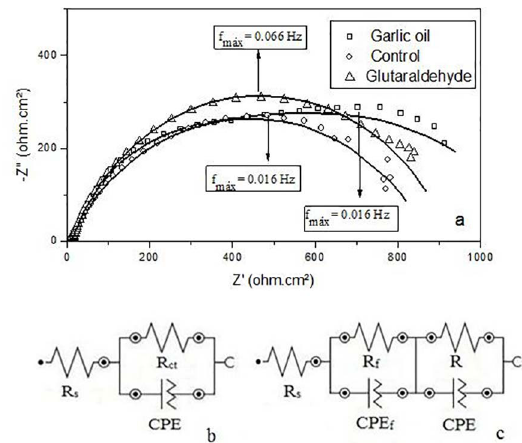
Figure 5. (a) Nyquist diagrams for the 1020 carbon steel in synthetic seawater. (b) Equivalent circuit model used to simulate the EIS data of the tests with glutaraldehyde biocide and control. (c) Equivalent circuit model used to simulate the EIS data of the test with garlic oil